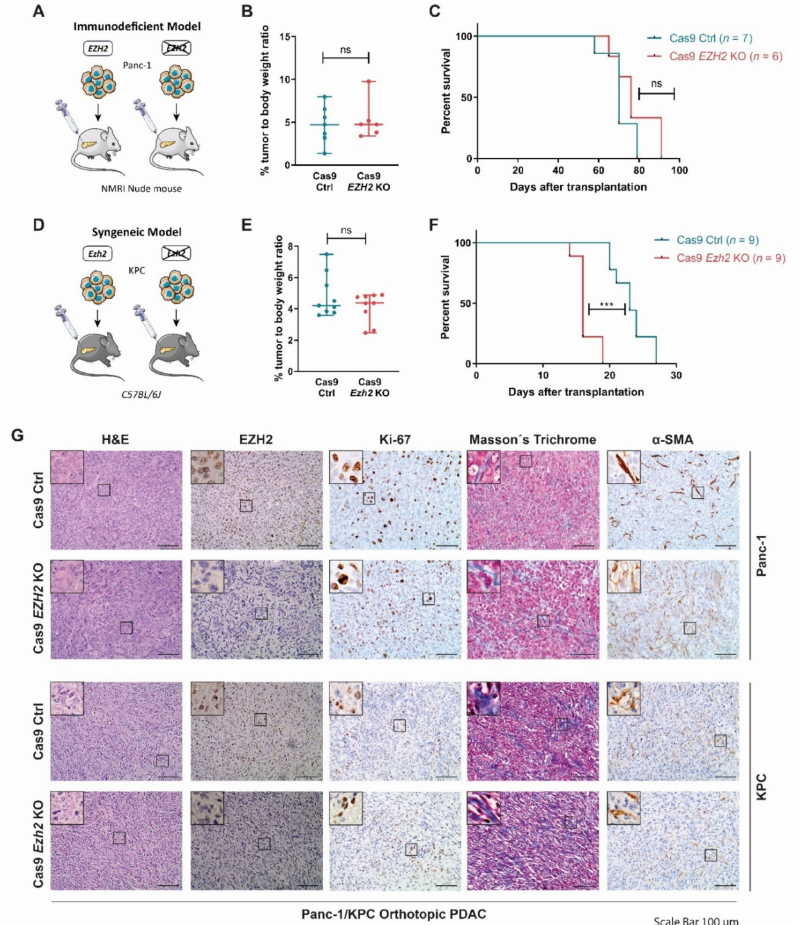
Figure 1. EZH2 depletion is not beneficial in orthotopic PDAC models. ( A ) Schematic illustration of orthotopically transplanted EZH2 expressing (Cas9 Ctrl) and CRISPR/Cas9-mediated EZH2